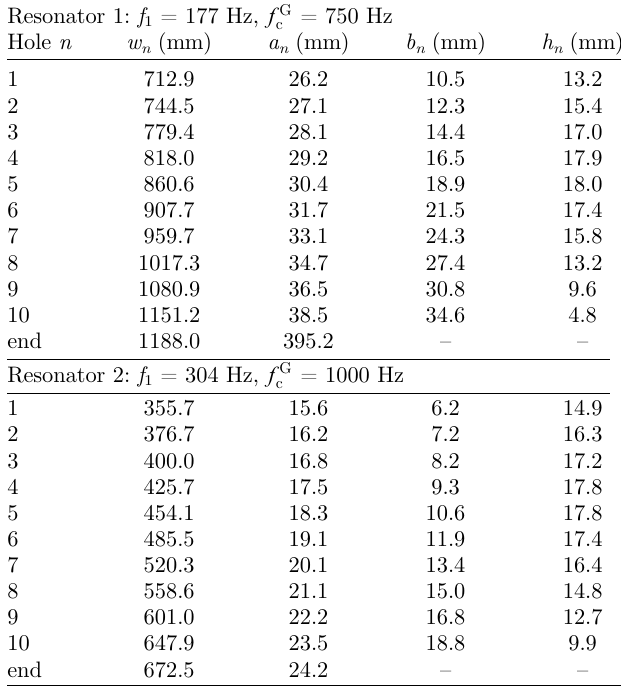
Table A1. Dimensions of two acoustically regular resonators with different fi rst impedance peak and theoretical global cutoff frequencies. Both resonators have an apex angle h = 0.028 rad and input radius a in = 6.25 mm. The distance from the input to the n th hole is denoted w n = r n (cid:3) x 1 , where x 1 is determined from the the apex angle and input